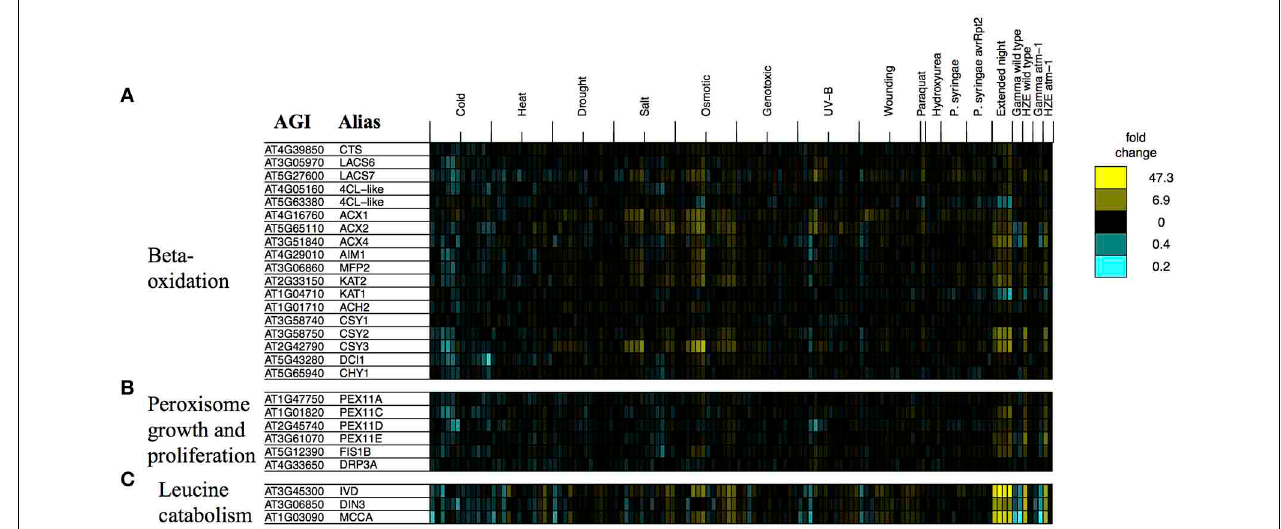
FIGURE 8 | Stress profiles of transcripts associated with extended night. For transcripts related to key biological processes that appear to be transcriptionally activated in response to both HZE (early response) and extended night- (A) beta-oxidation, (B) peroxisome growth and proliferation,